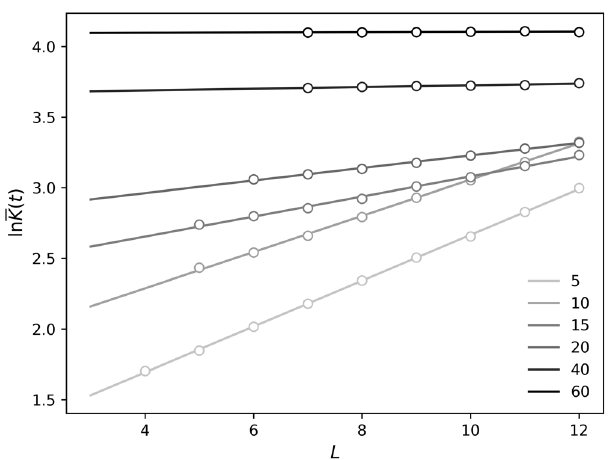
FIG. 30. Logarithm of the average SFF with open boundary ¯ K ð t Þ conditions, ln , versus system length L for various times t (legend). From linear fits at each time, we extract the leading eigenvalue in the ω ¼ 0 sector, λ ð 0 ; t Þ , and the overlap of the corresponding left and right eigenvectors with the boundary states, h B L j 0 ; t ; R ih 0 ; t ; L j B R i